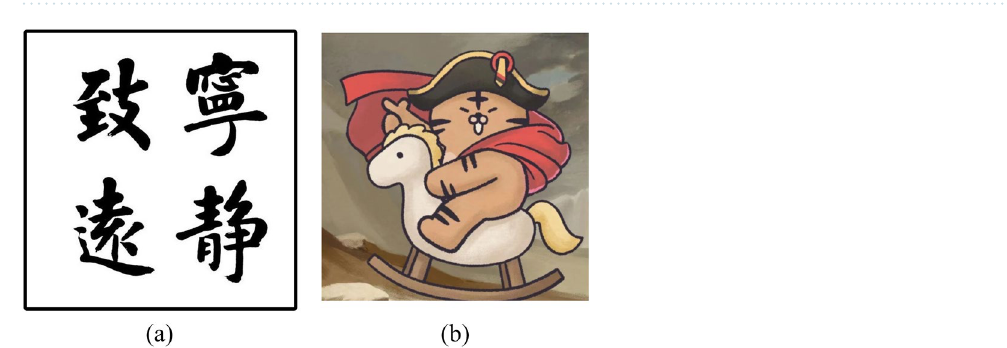
Figure 14. Relief renderings.